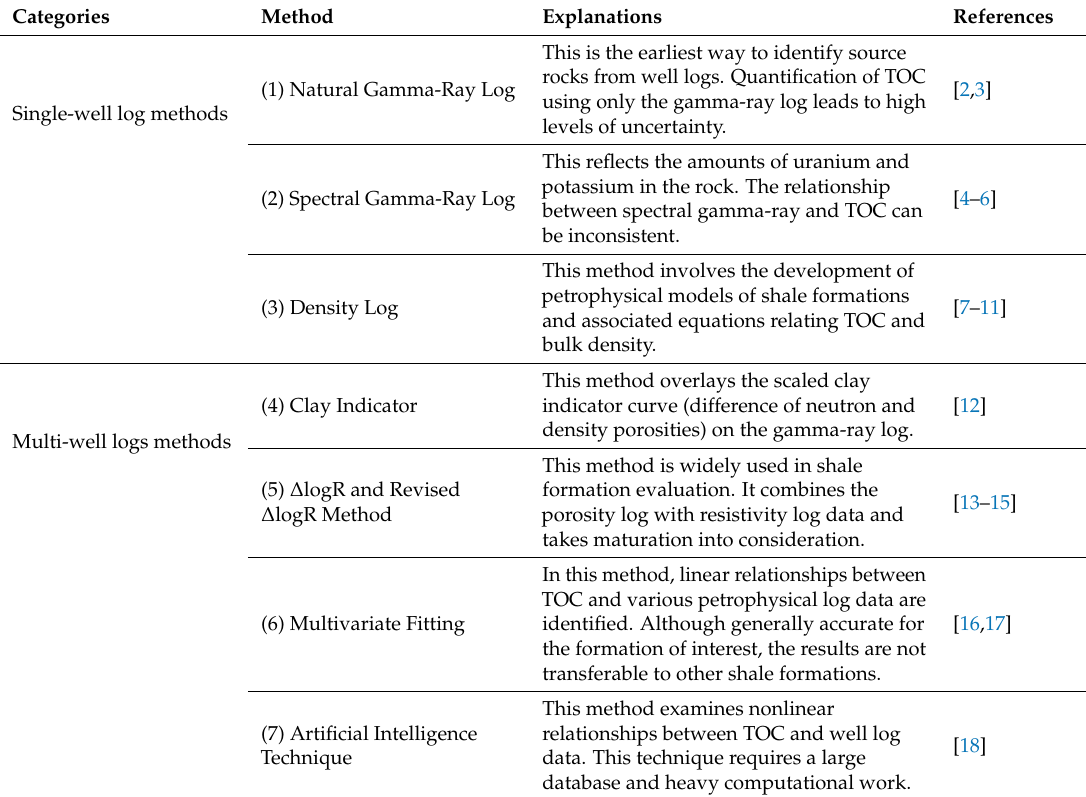
Table 1. Summary of log-based total organic carbon (TOC) estimation